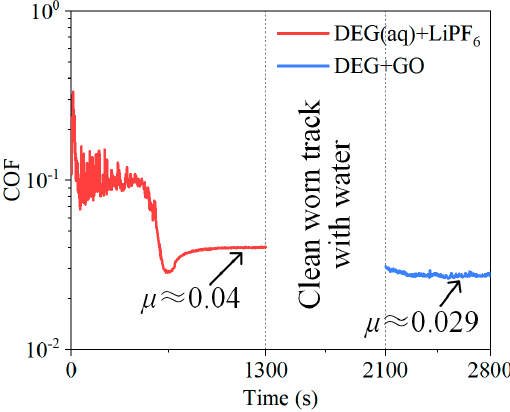
Figure 8. Result to prove GO nanoflakes further reduced COF based on tribochemical layer. Notably, DEG + GO solution contained no water. The conditions were 3 N, 100 mm/s, and 20 μ L. According to above analysis, a possible friction model for GO and LiPF 6 containing DA(aq) was proposed, as shown in Figure 9. The lubrication process contained two stages: the wear − in stage and superlubricity stage. In the wear − in stage, the water molecules in lubricants were volatilized rapidly through the wearing process, during which the lubri- cation regime was usually located at the boundary lubrication. Hence, the growth in lub- ricant viscosity caused by water volatilization was conducive to the film formation, which facilitated the improvement in lubrication and led to the drop in COF. Meanwhile, the conflict and wear of solid asperities led to the growth in contact area, and thus the reduc- tion in contact pressure. Therefore, a fluid layer was formed and kept relatively stable at the interface. Moreover, tribochemical reactions induced by rubbing motion led to the for- mation of a boundary layer containing phosphates, fluorides, and SiO 2 , which resulted in friction reduction as well. In addition to the fluid layer and tribochemical layer, the adhe- sive effect between contact surfaces and GO led to the adsorption of GO onto the contact surfaces. The GO adsorption layer at the interface could bear a part of the normal load, shield the contact surfaces, and make the shearing interface transfer from solid asperities to GO interlayers; and the weak interlayer interactions of GO further reduce friction dur- ing the steady lubrication stage. Therefore, it was the combination of the adsorption layer (GO) and tribochemical layer (LiPF 6 ) that significantly contributed to friction reduction in the mixed lubrication regime. Especially for DEG solution, the synergy effect of GO and LiPF 6 facilitated the realization of superlubricity. Although other factors, such as friction pair materials, high temperature, high speed, heavy load, etc., need to be considered in industrial lubrication, the results of this work proved that lubrication performance can be improved even to the superlubricity level by combining GO with proper materials, and proved GO − family materials as a promising industrial lubricant additive.